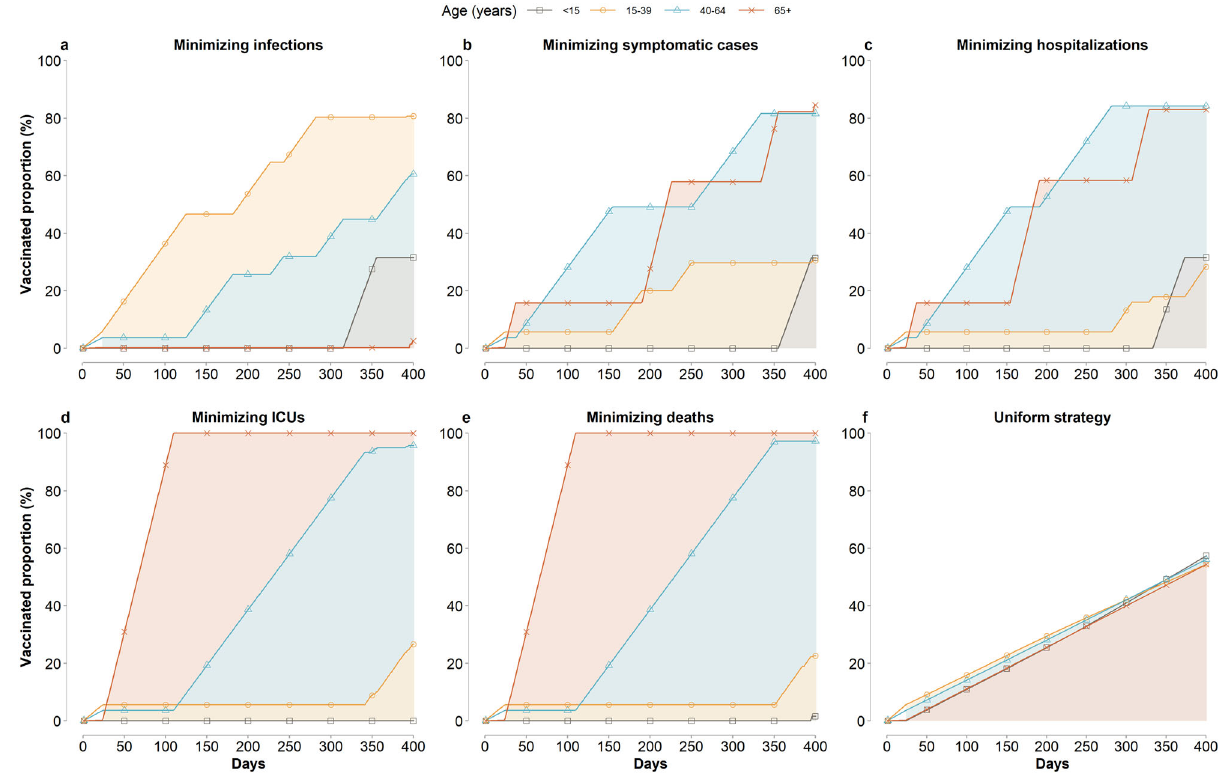
Fig. 1 Estimated vaccine coverages over time for different prioritization strategies (0.14% rollout speed, R = 1.5). a – e Five optimal prioritization strategies minimizing the total incidence of infections, symptomatic cases, hospitalizations, ICU admissions, and deaths, respectively. f Uniform vaccination strategy. Shaded area refers to vaccination capacity to the general populations. Lines refers to the vaccinated proportions including essential workers. Keys and labels apply to all